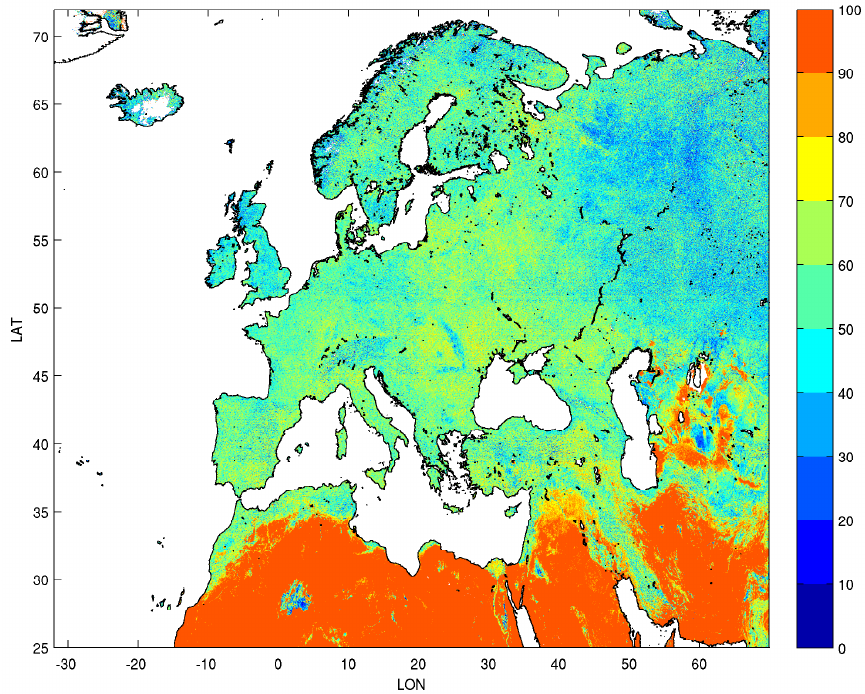
Figure 1. Percentage of spatial distribution of the coherency between the Sea-viewing Wide Field-of-view Sensor (SeaWiFS) and Medium Resolution Imaging Spectrometer Instrument (MERIS) Fraction of Absorbed Photosynthetically Active Radiation (FAPAR) products, estimated as the percentage of cases when the difference between these products does not exceed the sum of their respective temporal standard